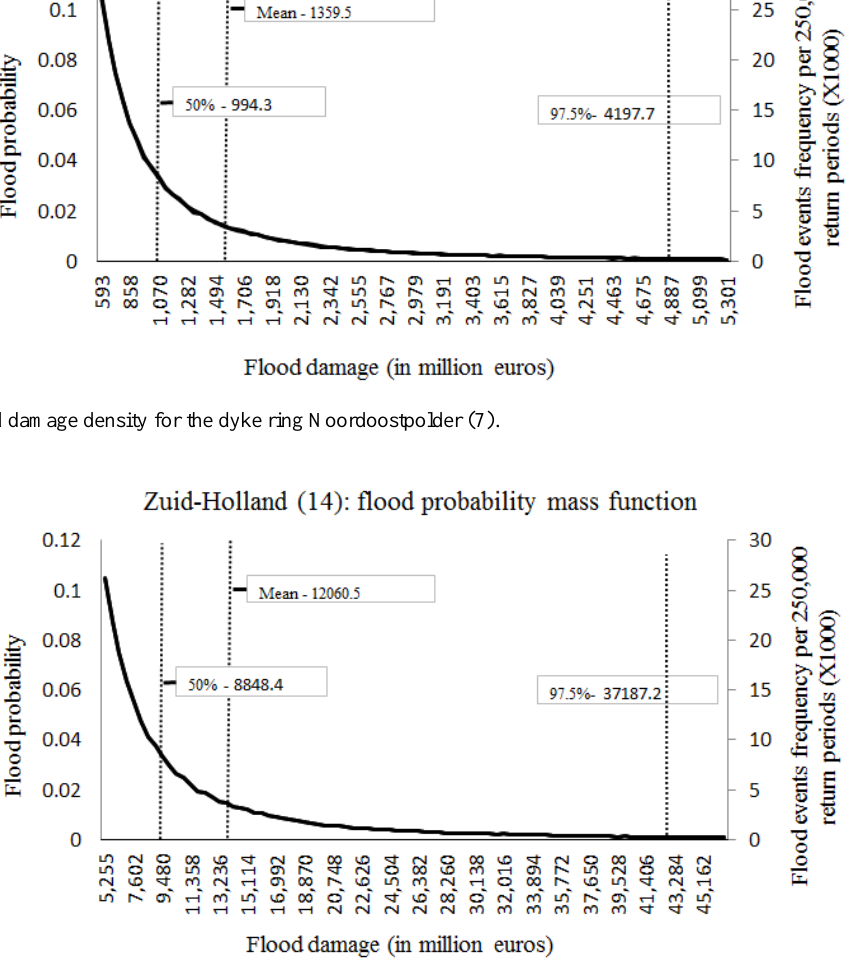
Fig. 4. Simulated flood damage density for the dyke ring Zuid Holland Figure 4: Simulated flood-damage density for the dyke-ring Zuid-Holland (14) Figure 4: Simulated flood-damage density for the dyke-ring Zuid-Holland (14)